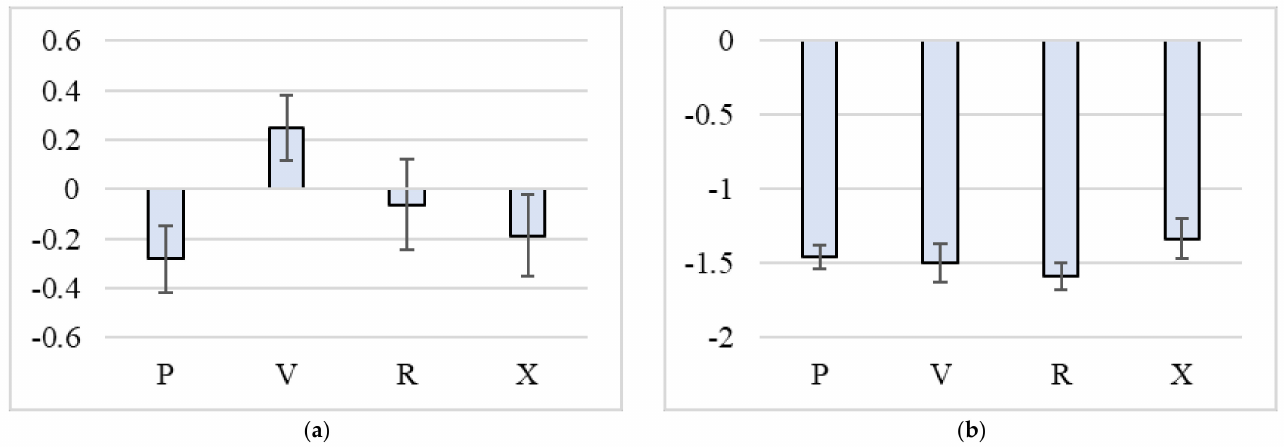
Figure 4. Average values ± standard error of the visual scores of the WSP obtained in ( a ) the central rows and ( b ) the adjacent rows, by the four sprayer